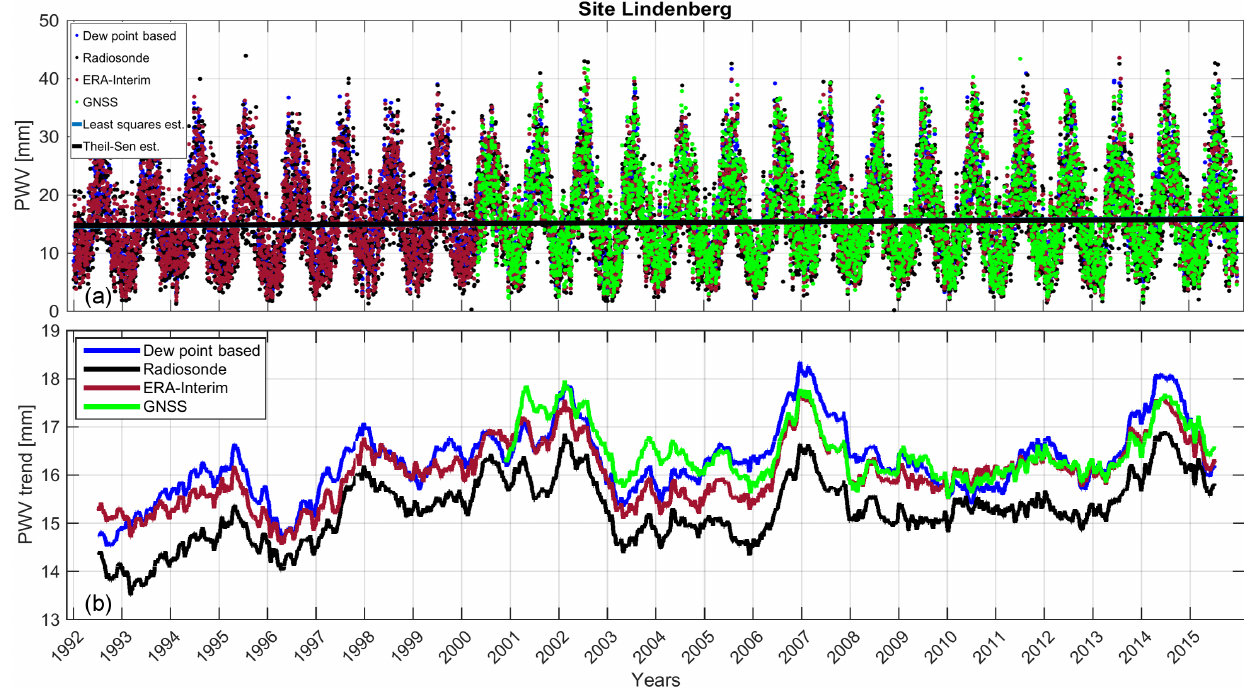
Figure 6. (a) Daily mean PWV time series at site Lindenberg from GNSS, ERA-Interim, and synoptic data (1992–2015). The PWV measured by a radiosonde at 12:00UTC is also shown. The trend extracted by removing the seasonal and irregular components are shown in panel (b)